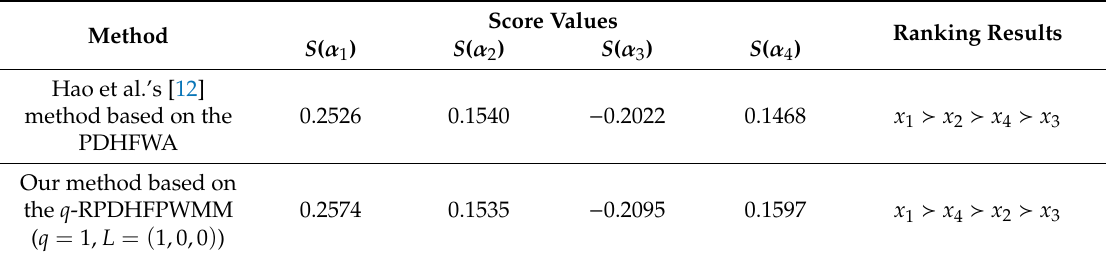
Table 10. The score values and ranking results utilizing di ff erent methods in Example